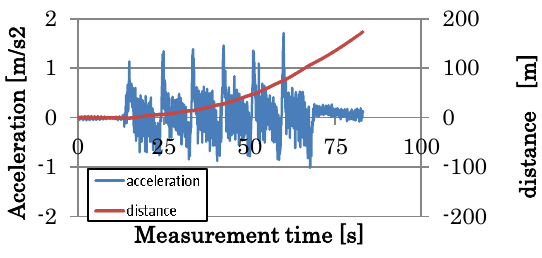
Fig. 10 X-axis acceleration and position of